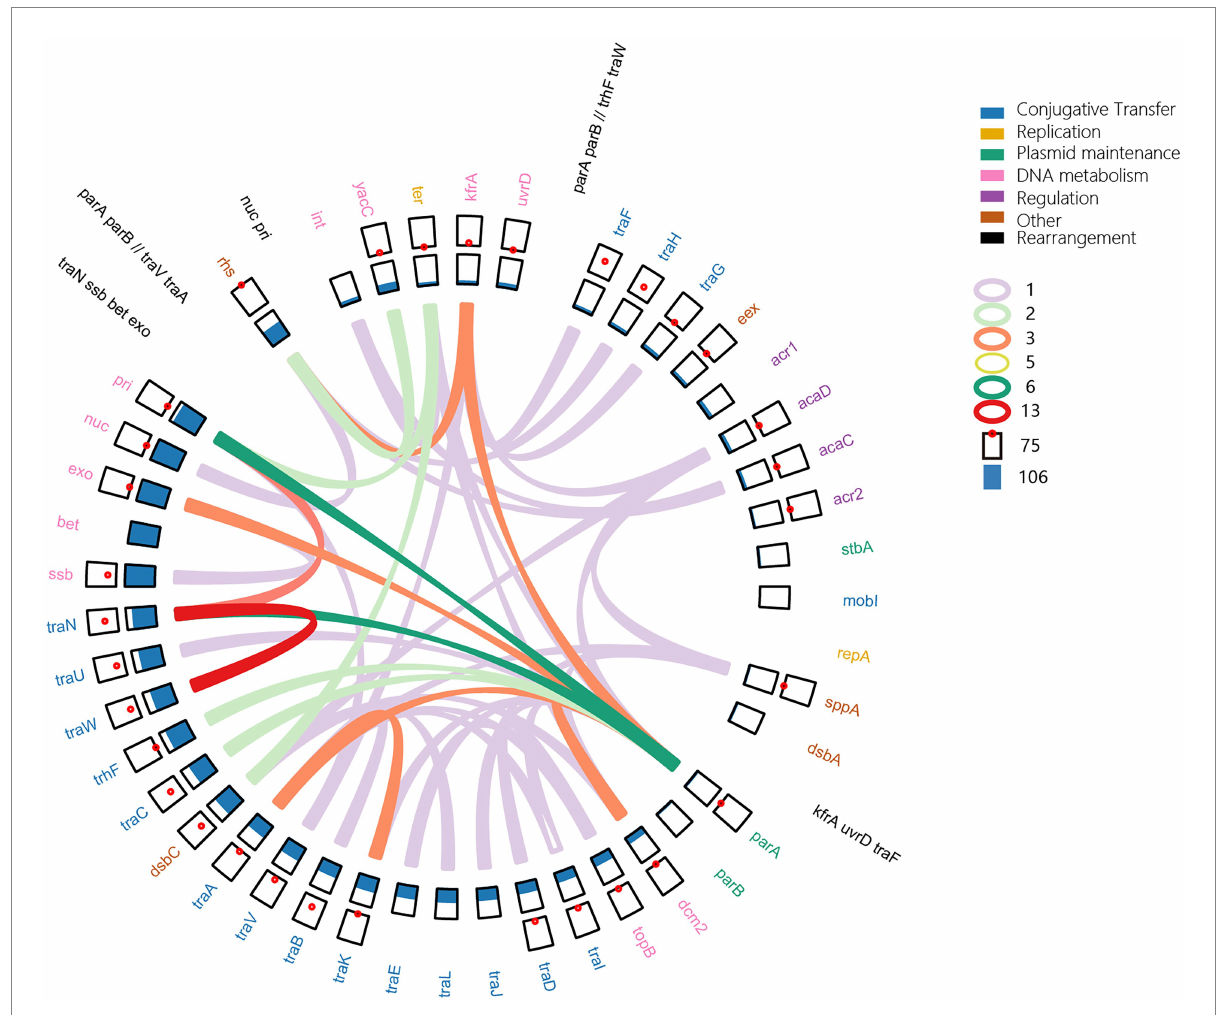
FIGURE 5 Dynamic structure of the IncA and IncC plasmid backbones. In the outside ring, the black gene clusters show the rearrangements. In the second ring, the coloured genes represent the shared backbone and the function of genes. All of the point plots and bar plots represent the number of genes with duplication and deletion in plasmids, respectively. The coloured arcs indicate that the gene fragments are inverted clockwise from the start genes to the end